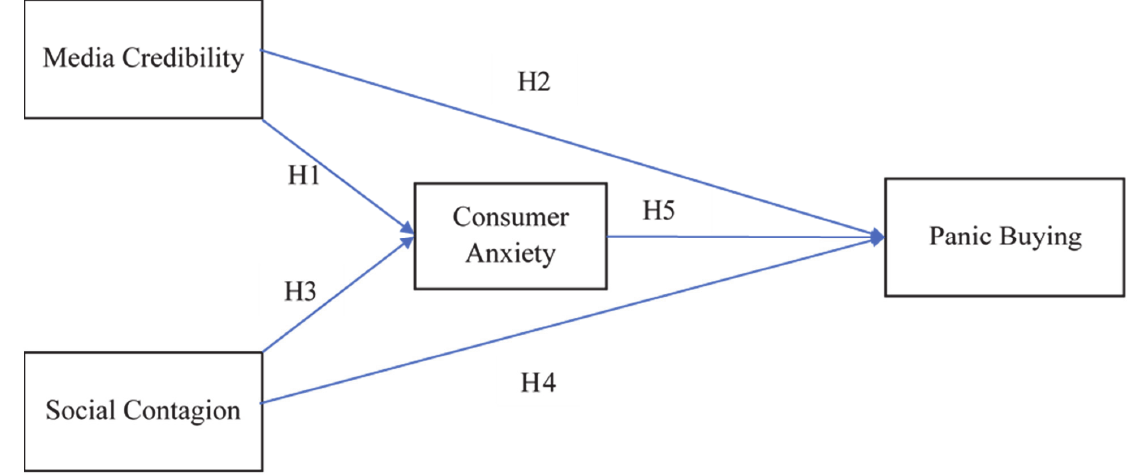
Fig. 1. Theoretical